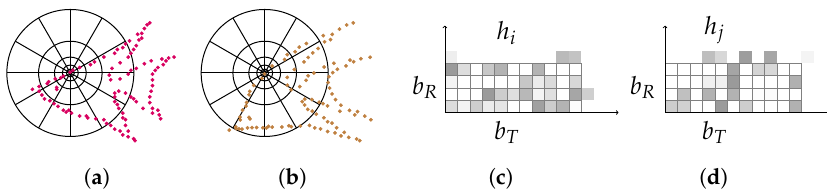
Figure 1. Illustration of the SC. ( a ) and ( b ): diagrams of log-polar histogram bins centered at x i and y j used in computing the shape contexts. ( c ) and ( d ): each shape context e.g., h i or h j is a log-polar histogram of the coordinates of the rest of the point set measured using the centered point as the origin, where darker denotes larger value.